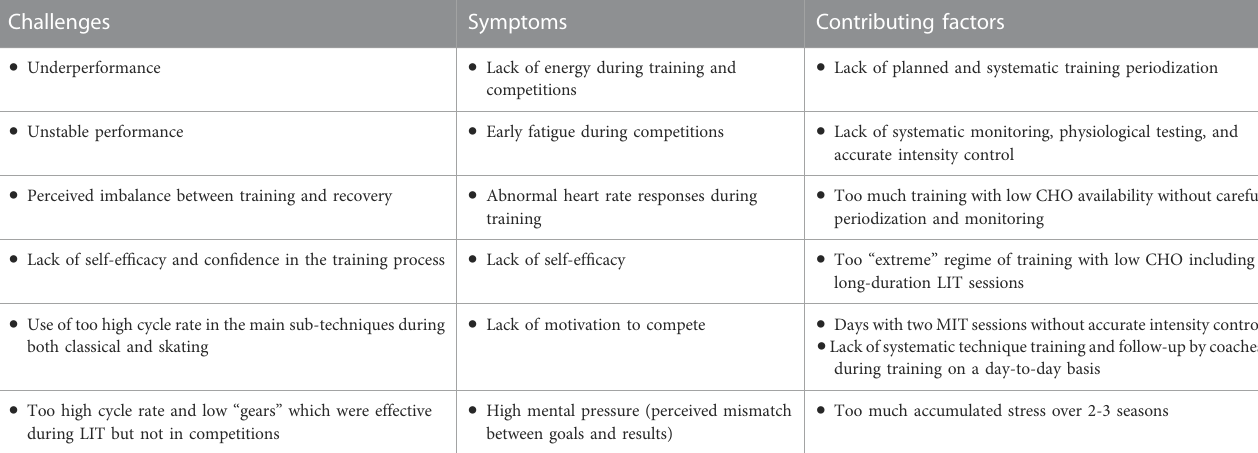
TABLE 1 Different challenges, symptoms, and possible contributing factors associated with unexpected underperformance over two seasons in a world-class male cross-country skier.